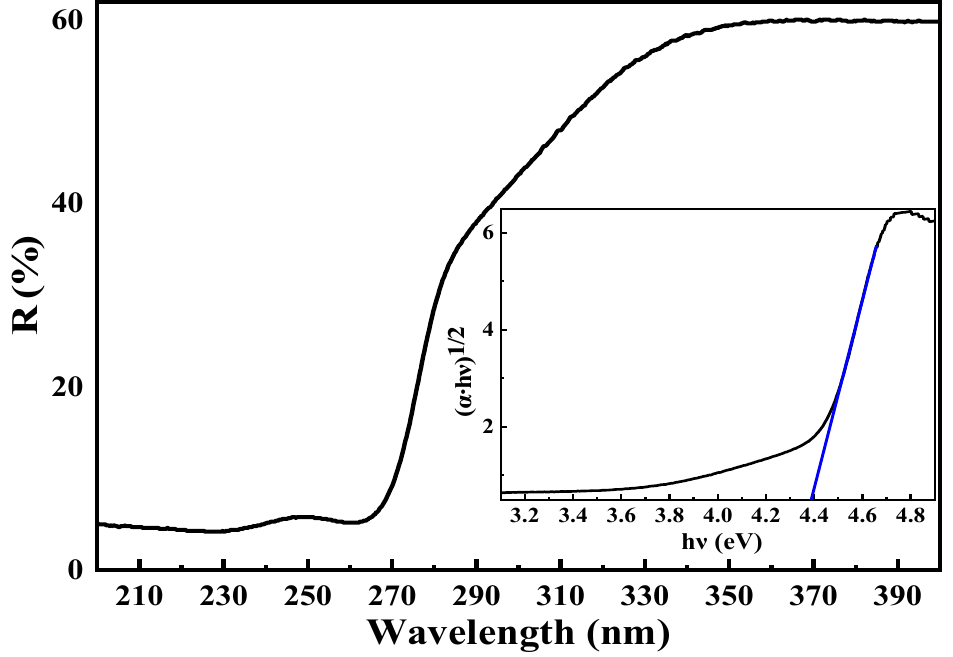
Figure 5. UV-Vis diffuse reflectance of BiP-500 with inset of the band gap energy obtained by Tauc’s plot (indirect band